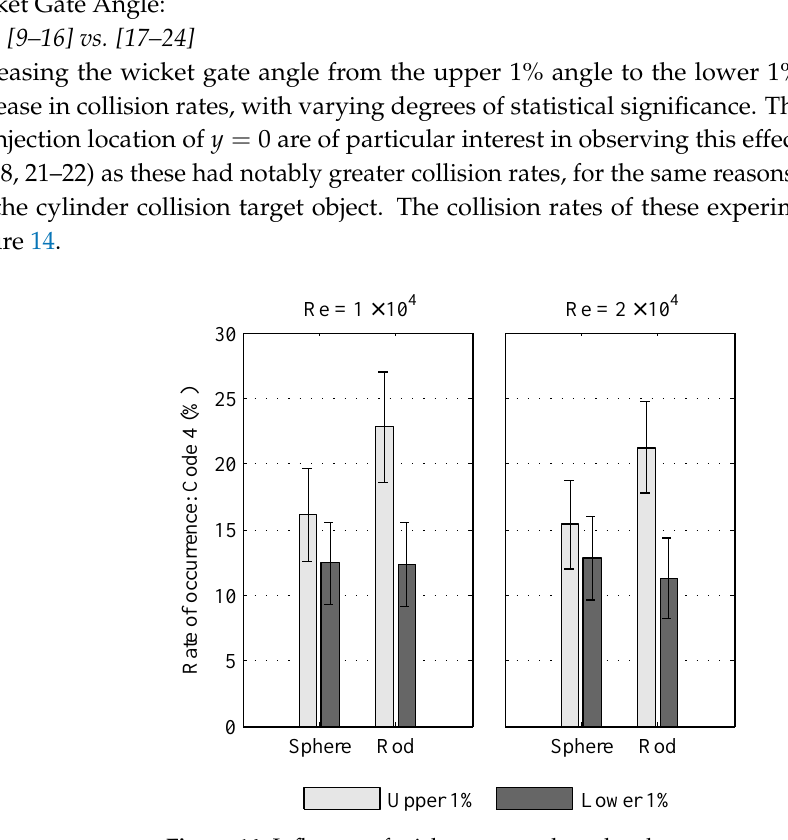
Figure 14. Influence of wicket gate angle on bead